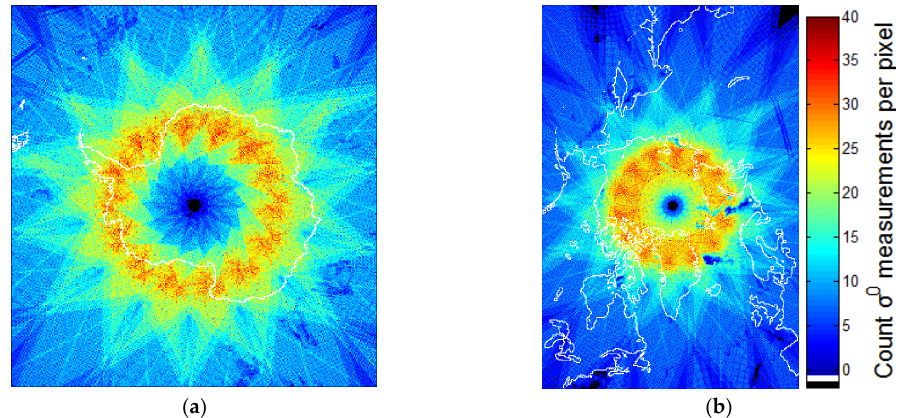
Figure 2. HY-2A/SCAT σ 0 count distribution in ( a ) Antarctic and ( b ) Arctic on 20 September 2013. The black area represents for no observation and the white lines is coastline, while other colors are count of σ 0 measurements per